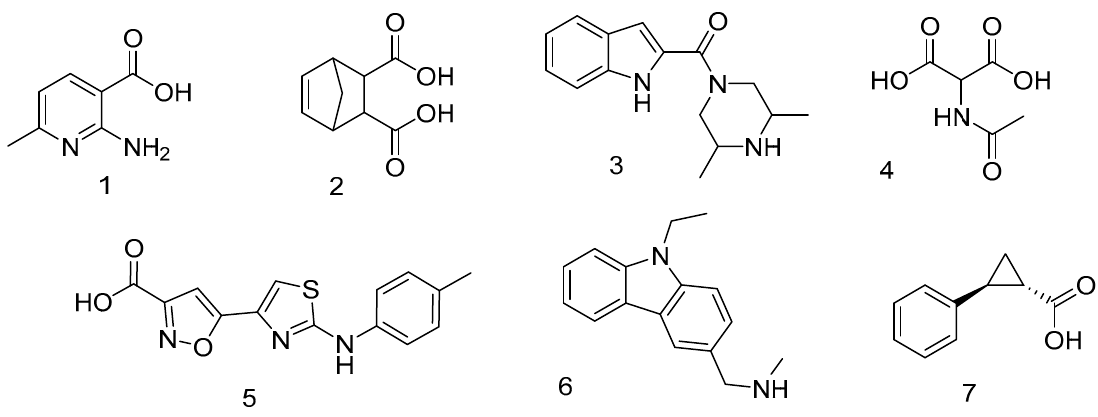
Figure 2. Compounds from the virtual screening.